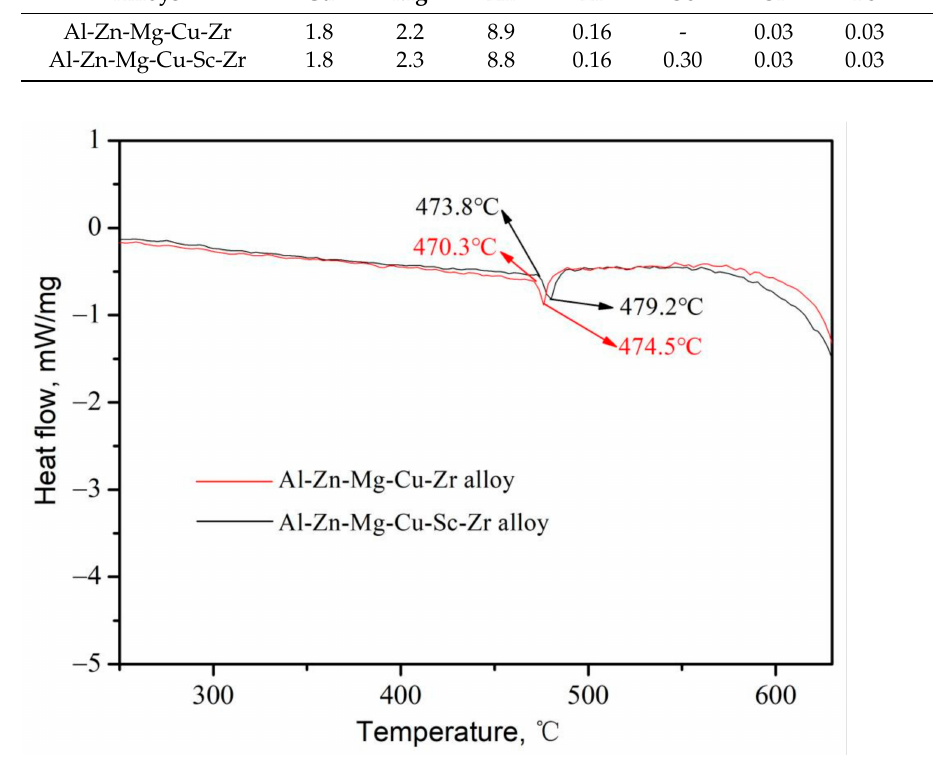
Figure 1. DSC curves of Al-Zn-Mg-Cu alloys in the as-cast condition. The samples for the microstructure characterization and IGC corrosion experiments were taken from the plates along the central axis of the longitudinal direction. The Vickers hardness tests for the samples that underwent the different solid solution treatments were carried out on a Zwick/Roell machine (Indentec hardness testing machine limited, West Midlands, UK) and the hardness result of each piece was obtained by calculating the average of nine measured values. The samples for optical observation were prepared by mechanical polishing and etching with Keller’s reagent for 10–20 s. The samples for the scanning electron microscope (SEM) observations were also prepared by mechanical